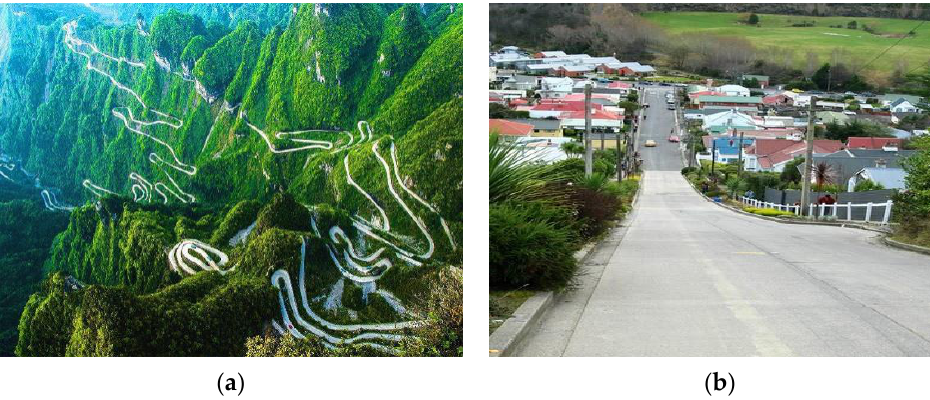
Figure 1. The actual road conditions with large longitudinal slope (pictures from internet). ( a ) Highway in mountainous area of China; ( b ) Baldwin Street in New Zealand.